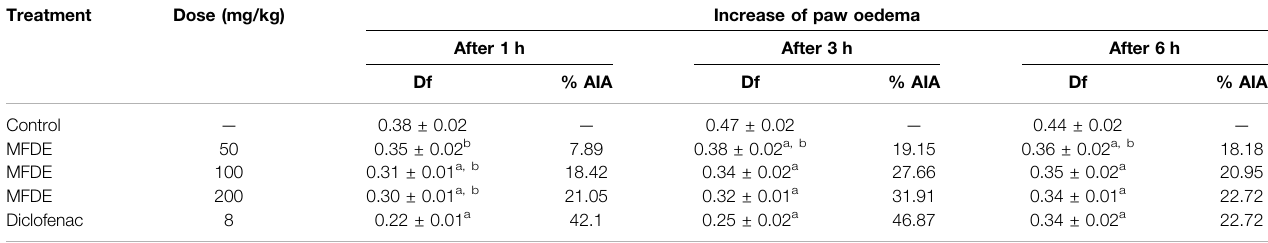
TABLE 3 | Effect of the MFDE on carrageenan-induced paw oedema in rats. Treatment Dose (mg/kg)